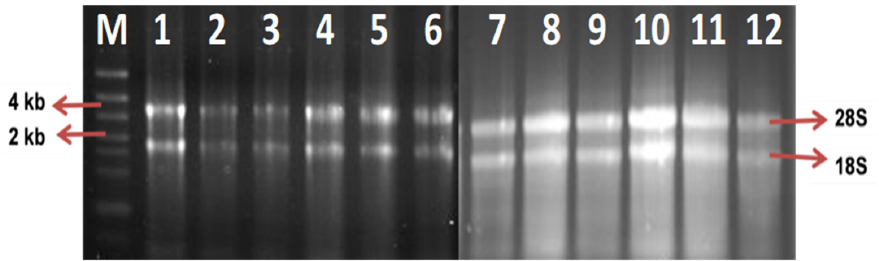
Figure 2. Total RNA of oil palm root tissues from oil palm seedlings (lanes 1–5) and mature palms (lanes 7–12) on 1.5% ( w / v ) agarose gel electrophoresis showed distinct 28S and 18S rRNAs bands. M: GeneRuler RNA Ladder High Range (Fermentas, Foster City, CA, USA).